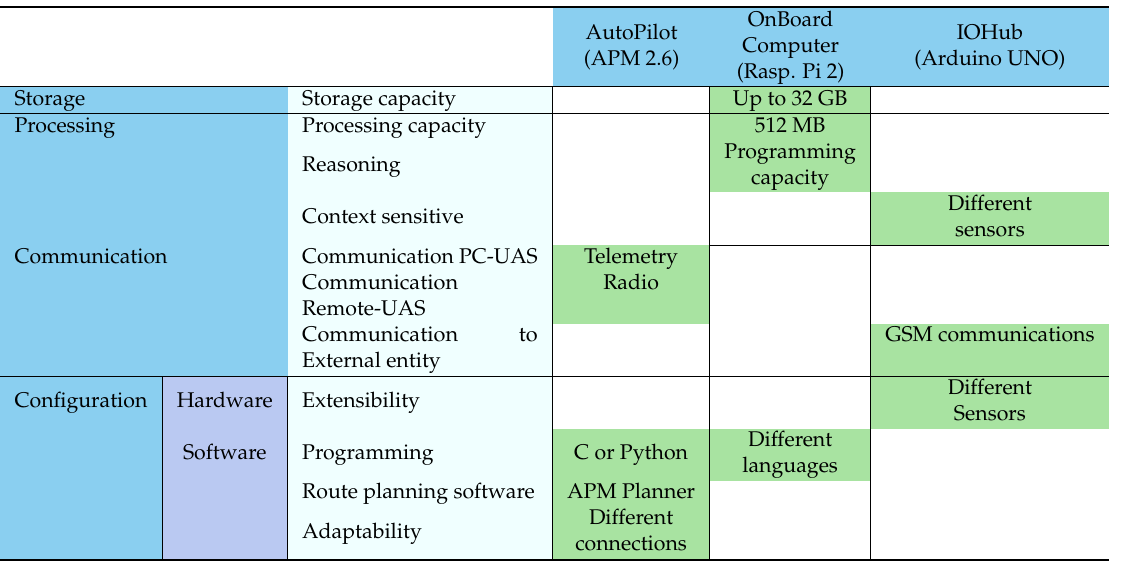
Table 11. Features provided by the UAS